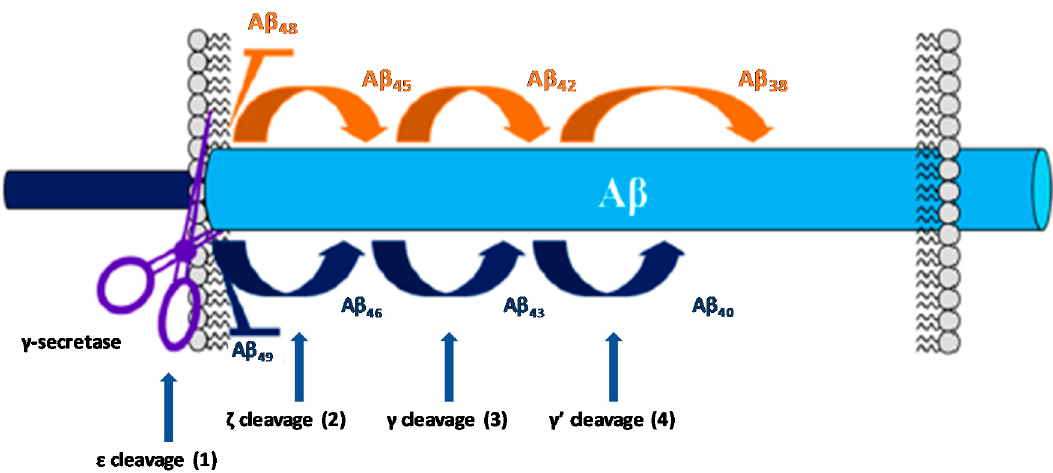
Figure 5. Cleavage steps of C99 by GS. Adapted with permission from [17]. Copyright 2016 American Chemical Society